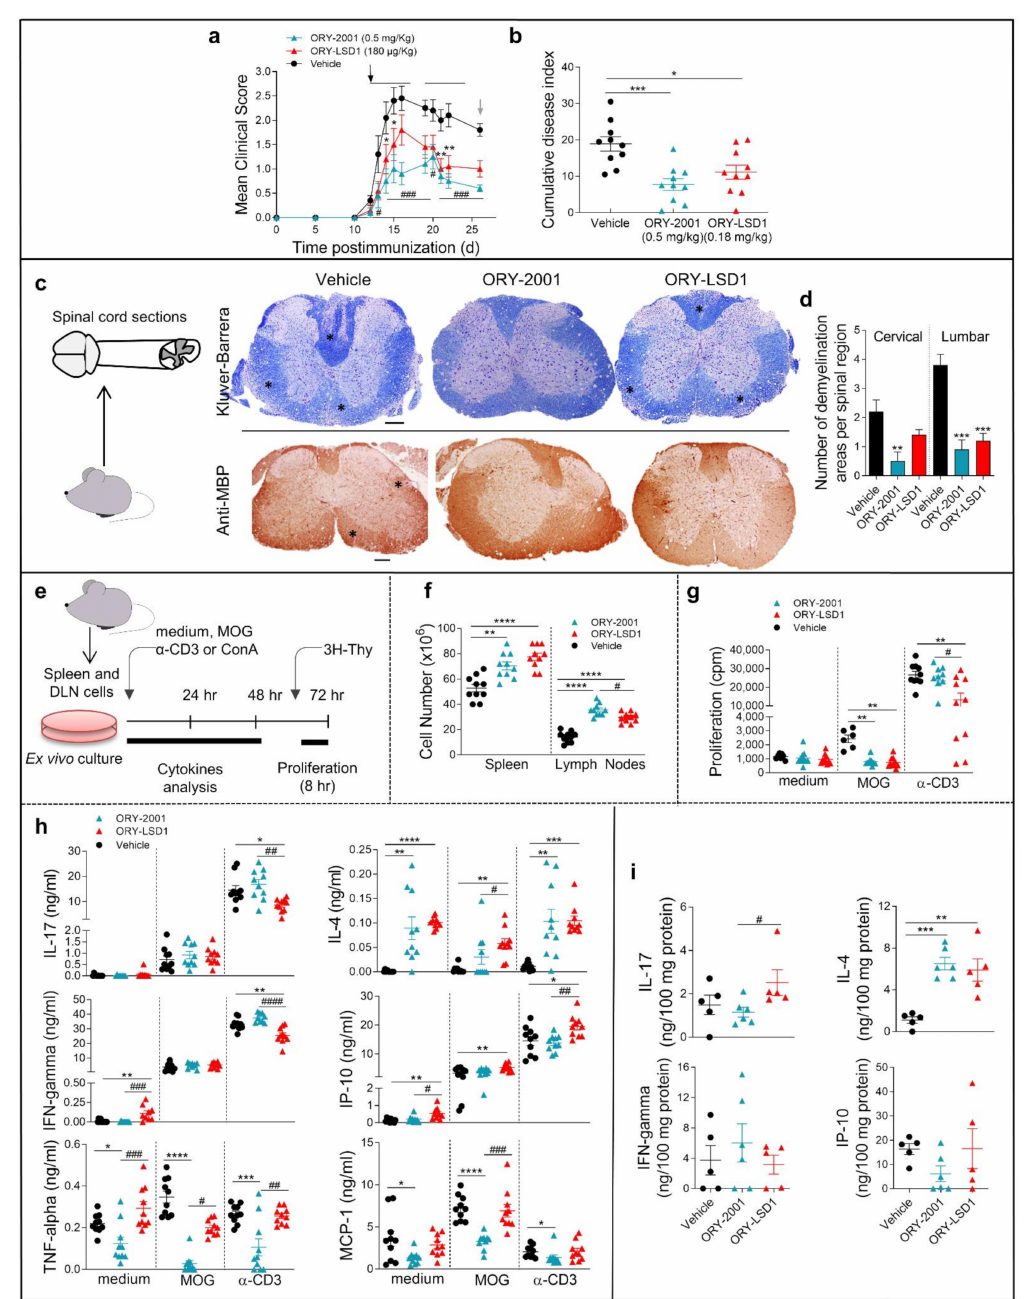
Figure 2. ORY-2001 protects from demyelination and inflammation in the EAE mice by modulat- ing the immune infiltration to the CNS. Mice with MOG 35–55 -induced chronic EAE were orally treated with vehicle, ORY-2001 (0.5 mg/kg) or ORY-LSD1 (180 µ g/kg) for two periods of five days (horizontal bars in ( a )) starting at the onset on day 12 (pointed by a black arrow, ( a )) Mean clinical score ( a ) and cumulative disease index ( b ) are showed for each group until animals were sacrificed (pointed by a grey arrow 26 days after immunization, sub-chronic phase). Data represent mean ± SEM. N = 10 mice/group; ( a ) * p < 0.05, ** p < 0.01 between vehicle and ORY-LSD1-treated mice; # p < 0.05, ### p < 0.0005 between vehicle and ORY-LSD1-treated mice; ( b ) * p < 0.05, *** p <